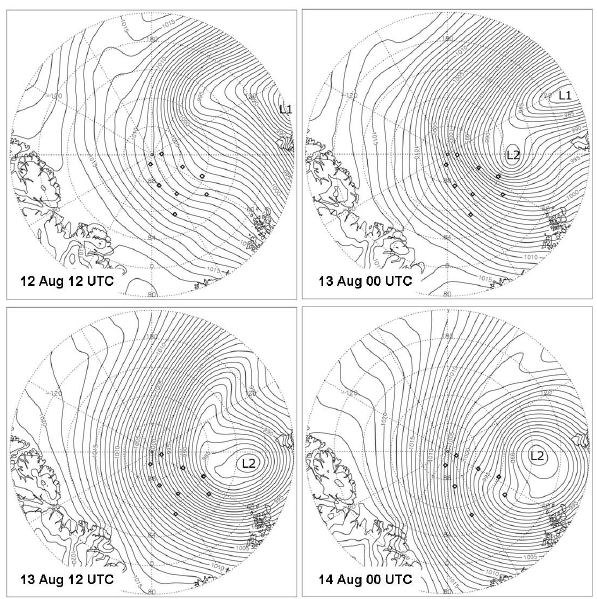
Fig. 11. Sea-level pressure fields from ECMWF operational analy- sis on 12 August, 12:00UTC, 13 August, 00:00UTC, 13 August, 12:00UTC, and 14 August, 00:00UTC together with simultaneous buoy positions. L1 and L2 mark low-pressure centres.